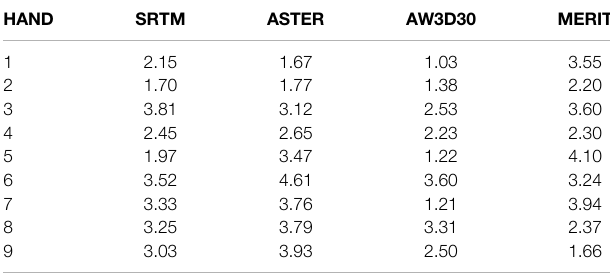
TABLE 4 | RMSE of each HAND value in 1-m increments for the global DEMs. HAND SRTM ASTER AW3D30